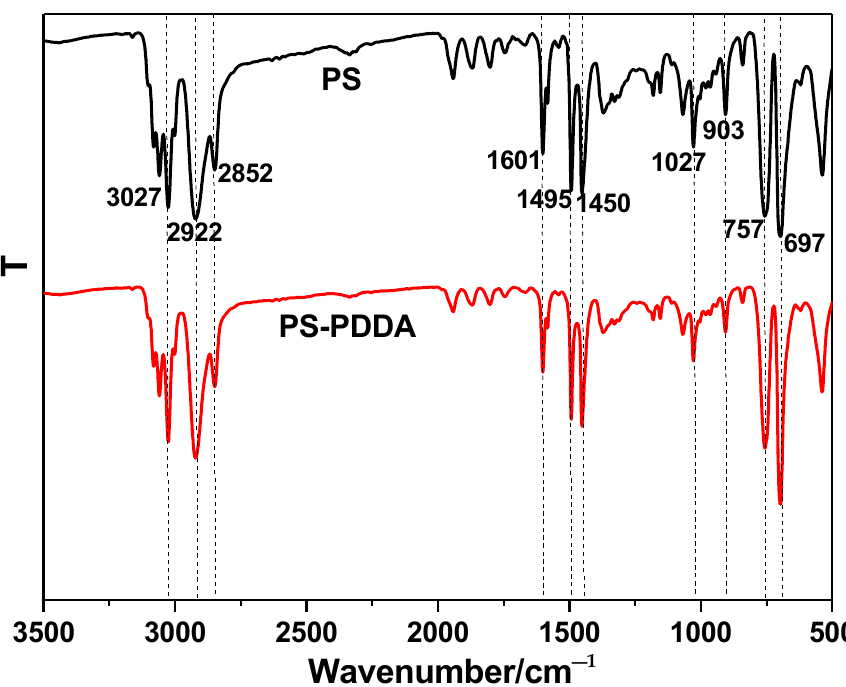
Figure 2. FTIR spectra of the PS spheres before and after PDDA modification.